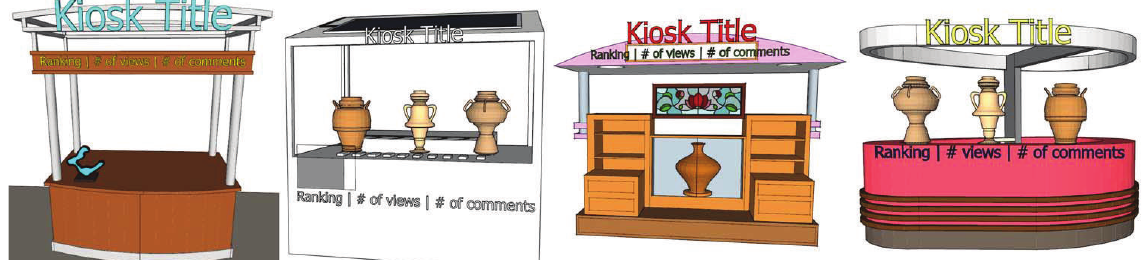
Figure 9: A snapshot of four different default kiosks used in KioskAR. The user selects one of these kiosks once establishing a virtual